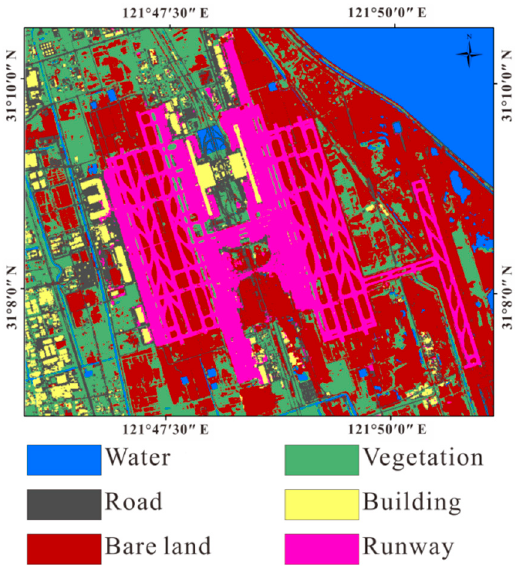
Figure 10. The classification result of Multi-source remote sensing data.